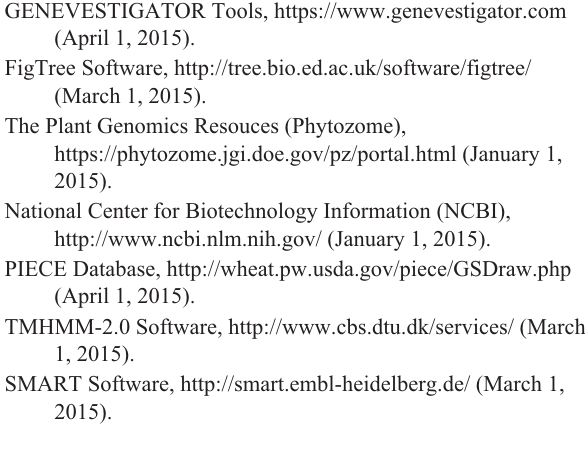
FigTree Software, http://tree.bio.ed.ac.uk/software/figtree/